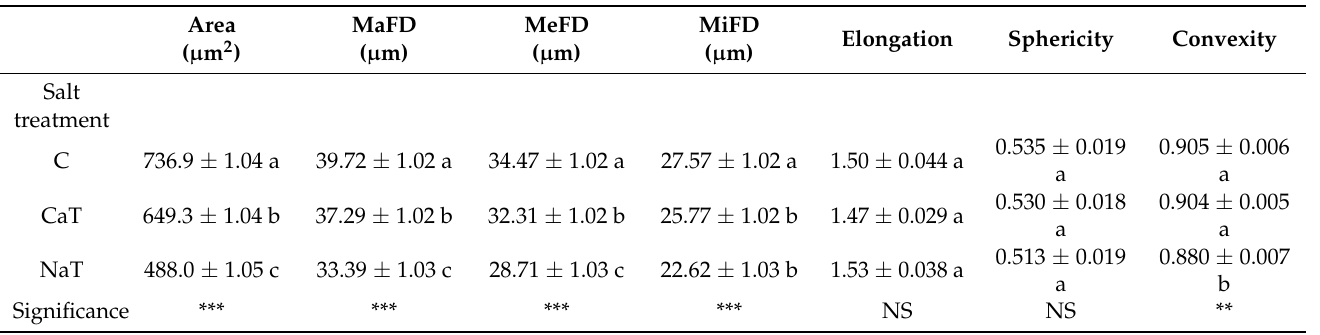
Table 4. Effects of salt treatment in the nutrient solution on area, maximum feret diameter (MaFD), mean feret diameter (MeFD), minimum feret diameter (MiFD), elongation, sphericity, and convexity of spongy parenchyma cells of leaves of C. citrinus plants. Mean values and standard errors are shown. Different letters correspond to significantly different values ( p <